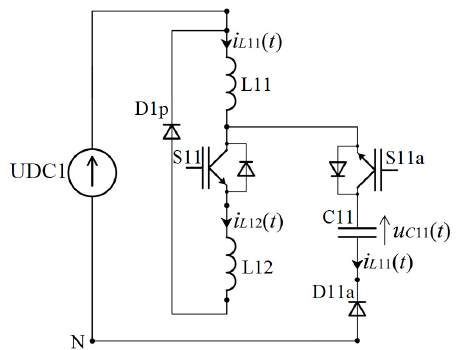
Figure 4. Currents in the stage t 16 – t 17 ; directions of currents and voltages according to Figure 1.